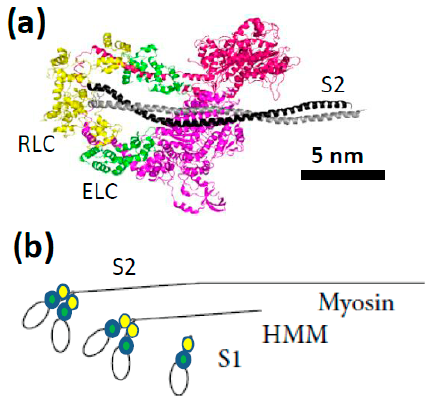
Figure 2. The myosin molecule and some key proteolytic fragments. ( a ) Crystal structure (PDB: 3DTP) showing two myosin motor domains with regulatory (yellow; RLC) and essential (green; ELC) light chains and a part of the sub-fragment 2 (S2) tail (black) of the myosin heavy chain. The construct is shown in the interacting head configuration believed to correspond to the super-relaxed state in muscle cells [40,41]; ( b ) schematic illustration of full length myosin and two soluble proteolytic fragments, heavy meromyosin (HMM) and sub-fragment 1 (S1) that are often used in single-molecule mechanics.